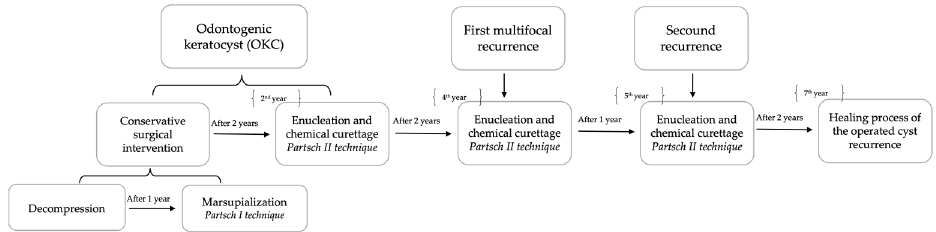
Figure 1. The patient evolution scheme from the first presentation.